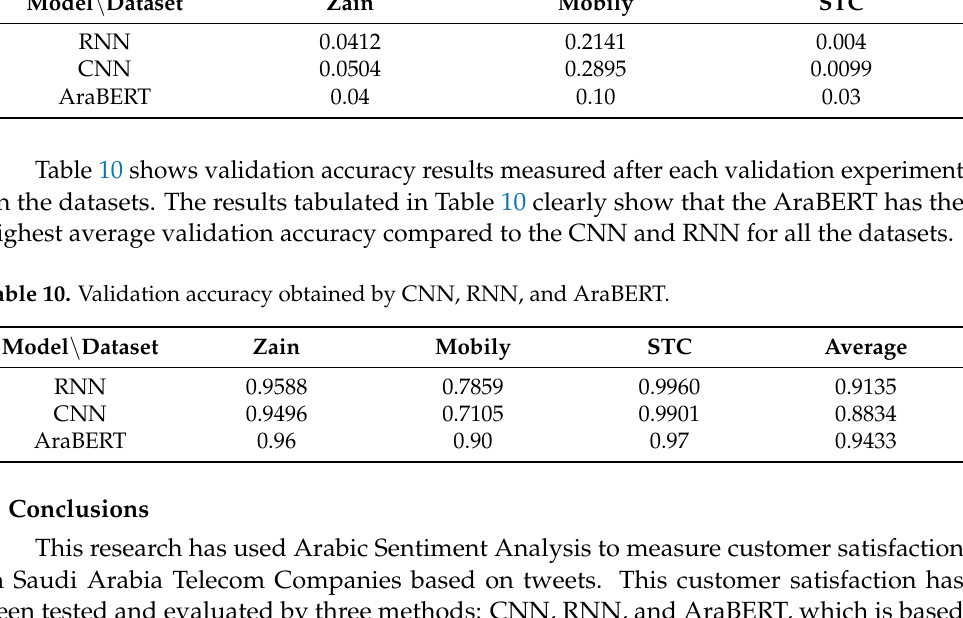
Table 9. Validation loss results obtained by CNN, RNN, and